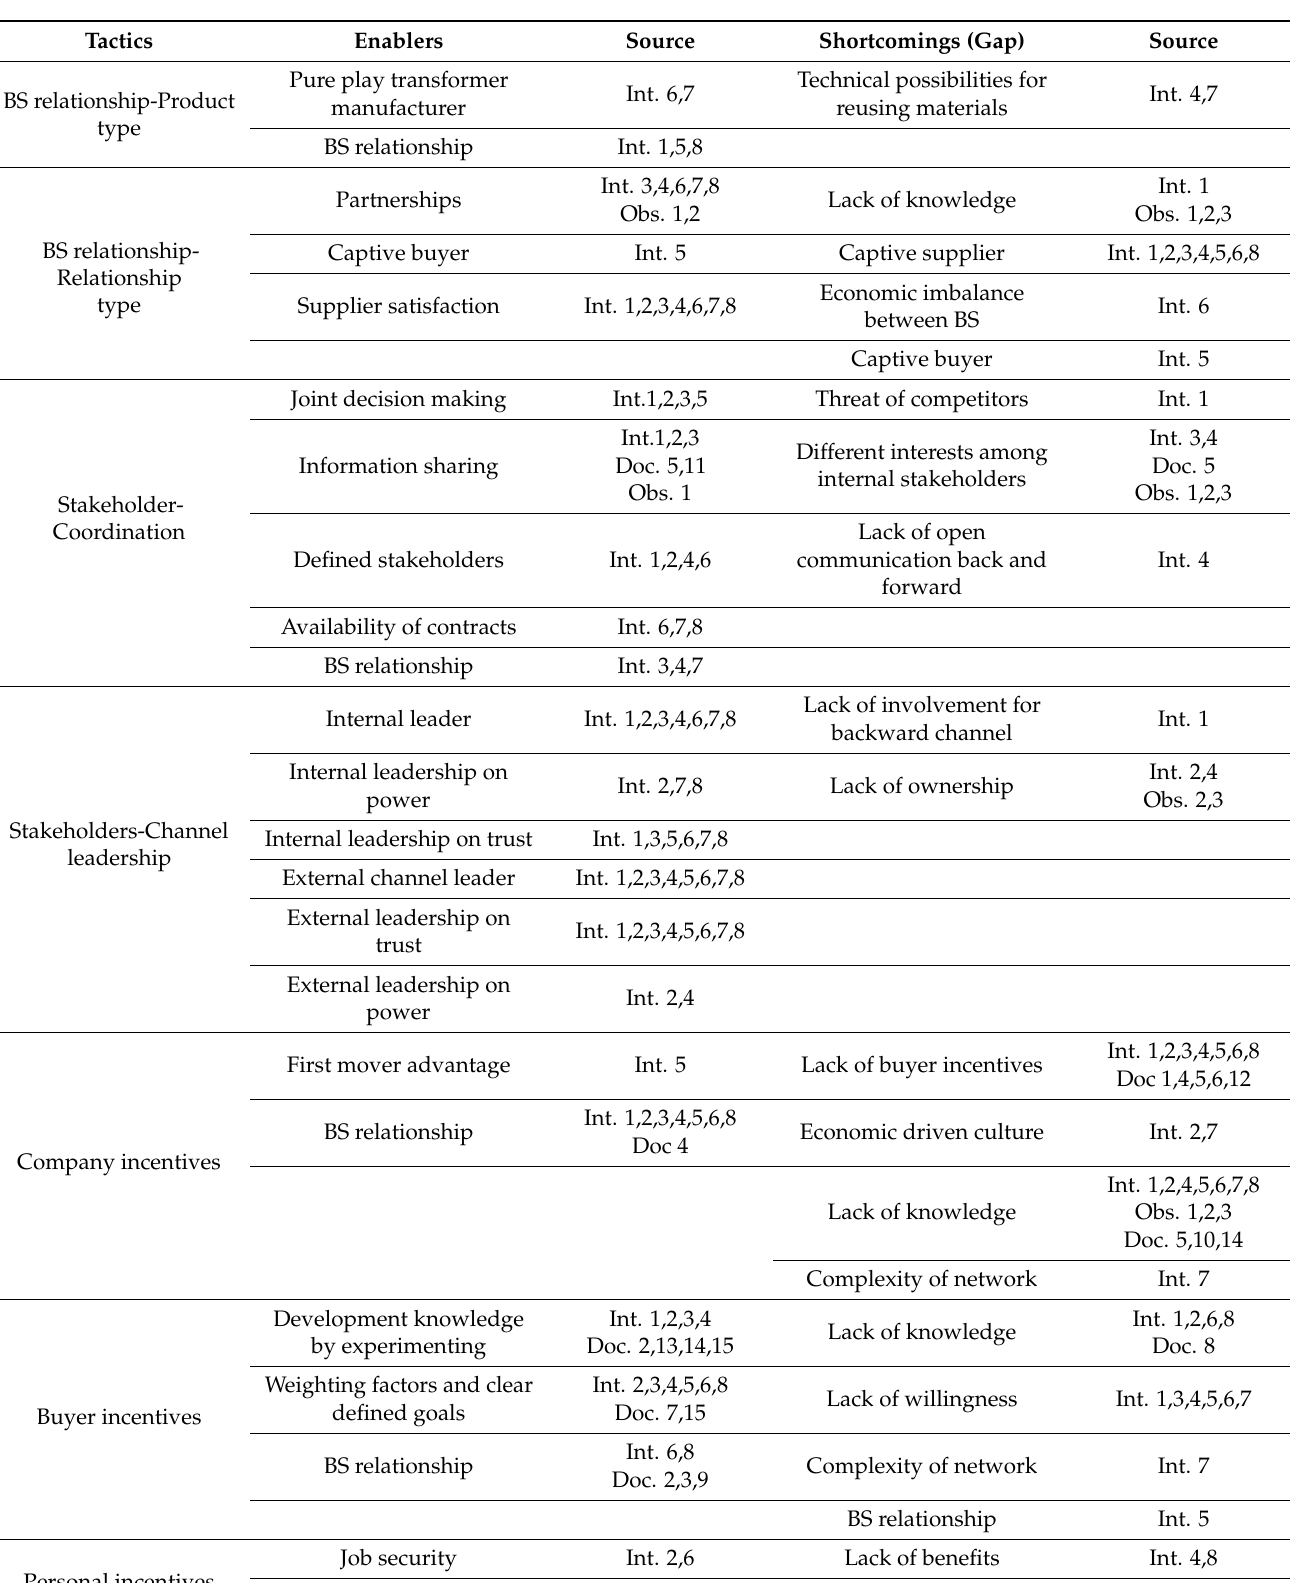
Table 5. Overview of supplier tactics and